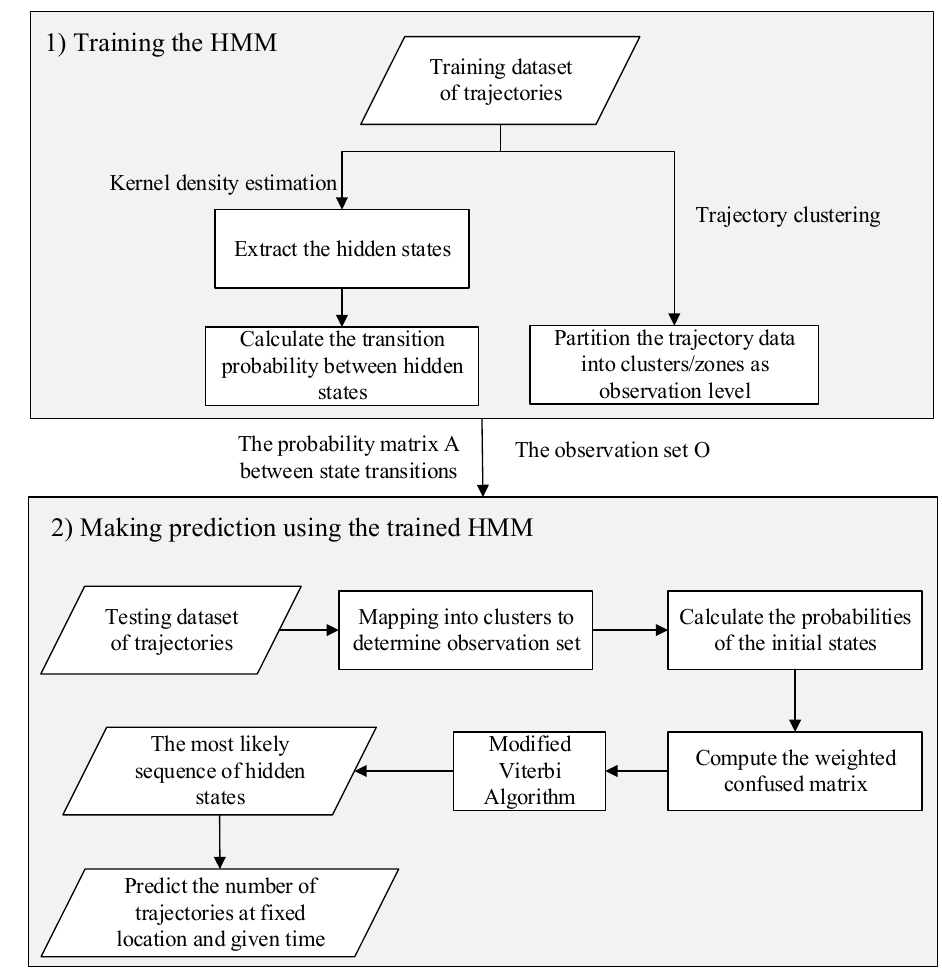
Figure 1. The framework of the predictive model. 200